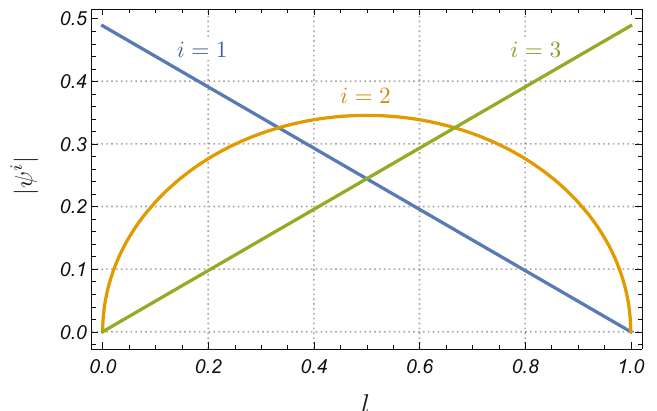
Figure 1 . Pro(cid:12)les of absolute values of spinor wavefunctions in l -coordinate with k = 1 and qM = 3. where i